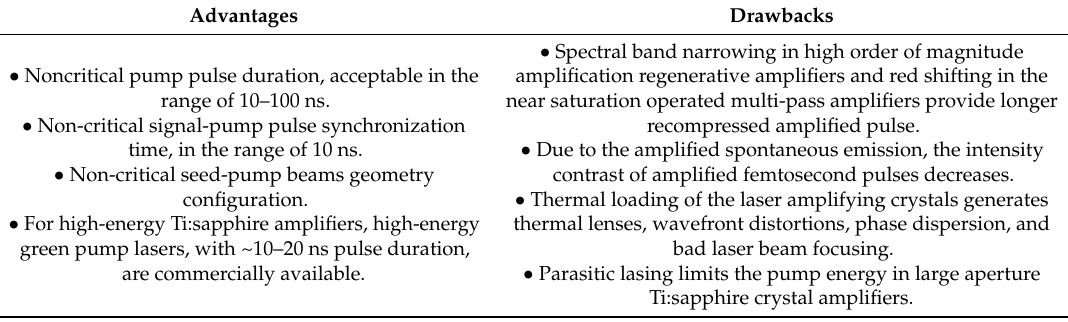
Table 3. The advantages and drawbacks of the large bandwidth laser pulses amplification